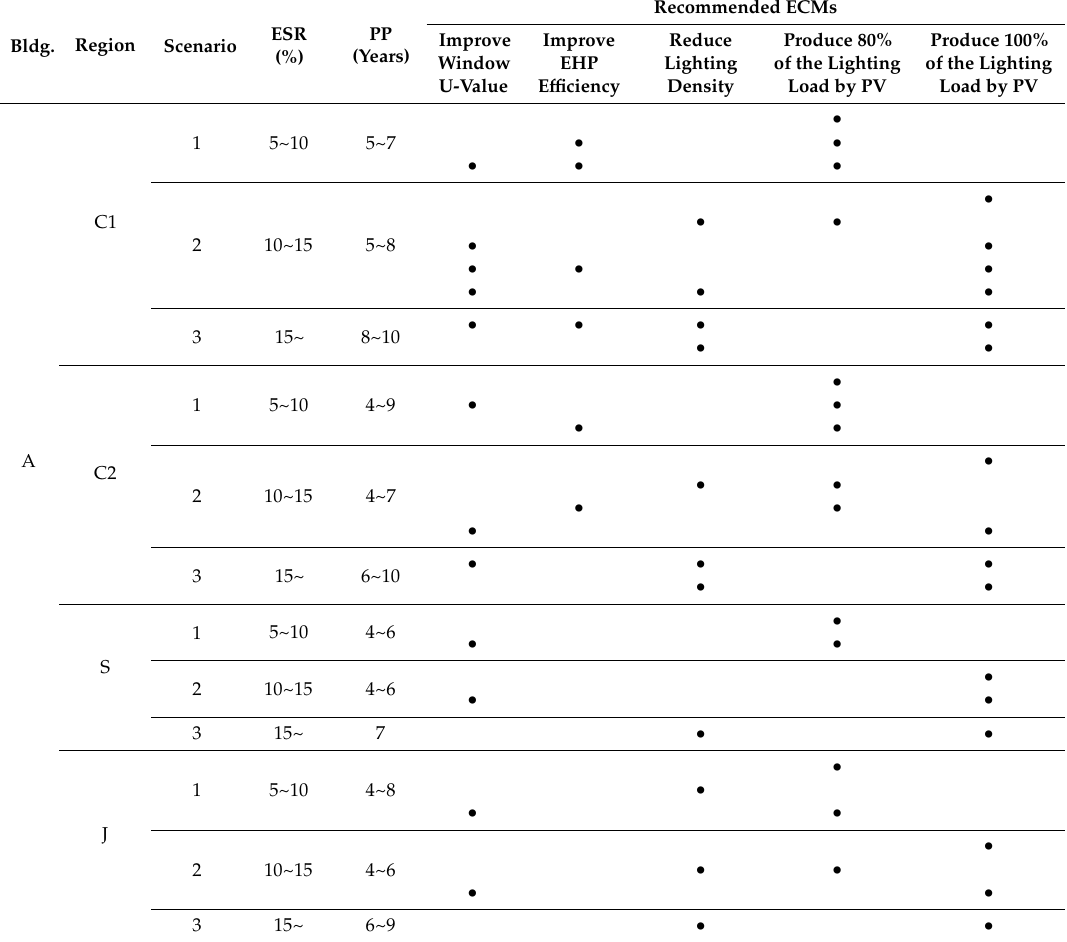
Table 16. Recommended ECM combinations according to the reinforcement scenarios of the BECC.